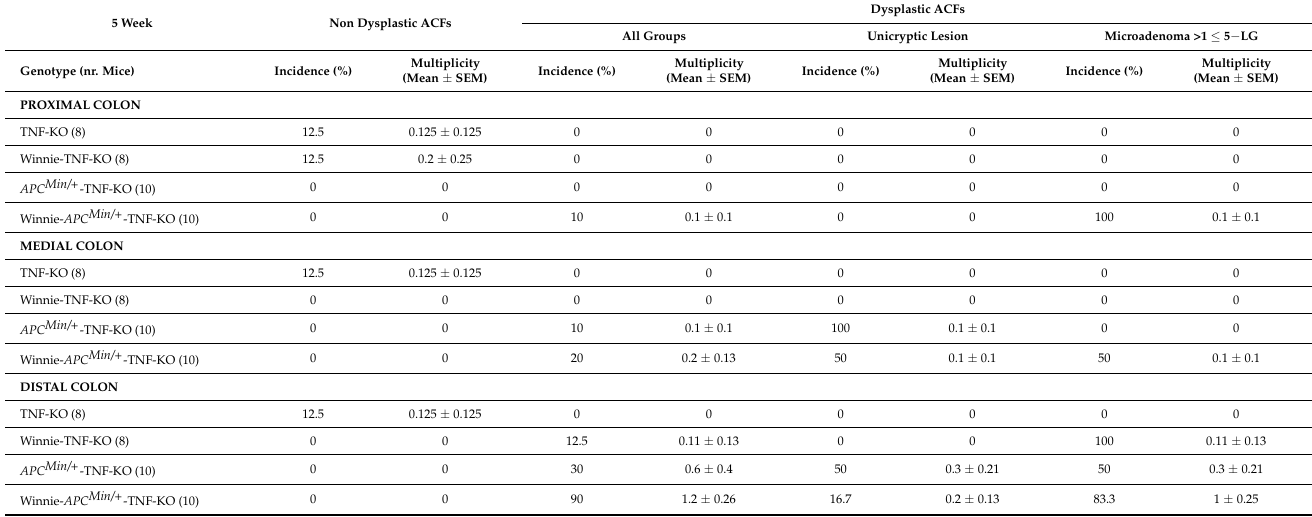
Figure 1. Creation and characterization of the Winnie- APC Min/+ -TNF-KO murine line. ( A ) Breeding strategy used to obtain Winnie- APC Min/+ -TNF-KO mice along with the control littermates. ( B ) Body weight analysis of 4-wk-old mice from different genotypes. Representative images of colons ( C ), data analysis of colon length ( D ), and colon length adjusted to the body weight ( E ) for Winnie- APC Min/+ -TNF-KO mice and control littermates. D-E: eight animals/group. Box plots represent the mean ± SEM. * p < 0.05, ** p < 0.01, *** p < 0.001, **** p < 0.0001 compared with TNF-KO mice. TNF: tumor necrosis factor.